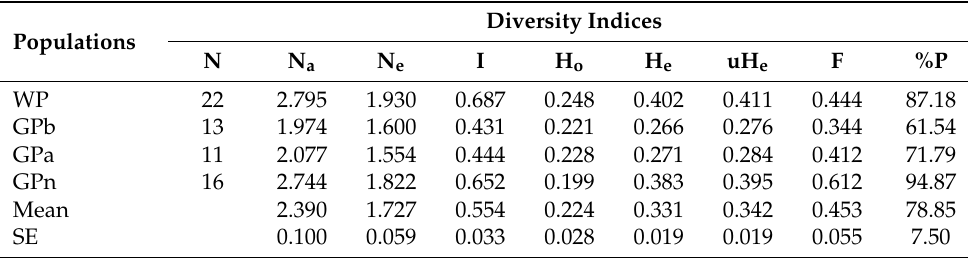
Table 1. Indices of genetic diversity from 4 populations of N. shimadai in northern Taiwan using 39 genomic SSR loci.